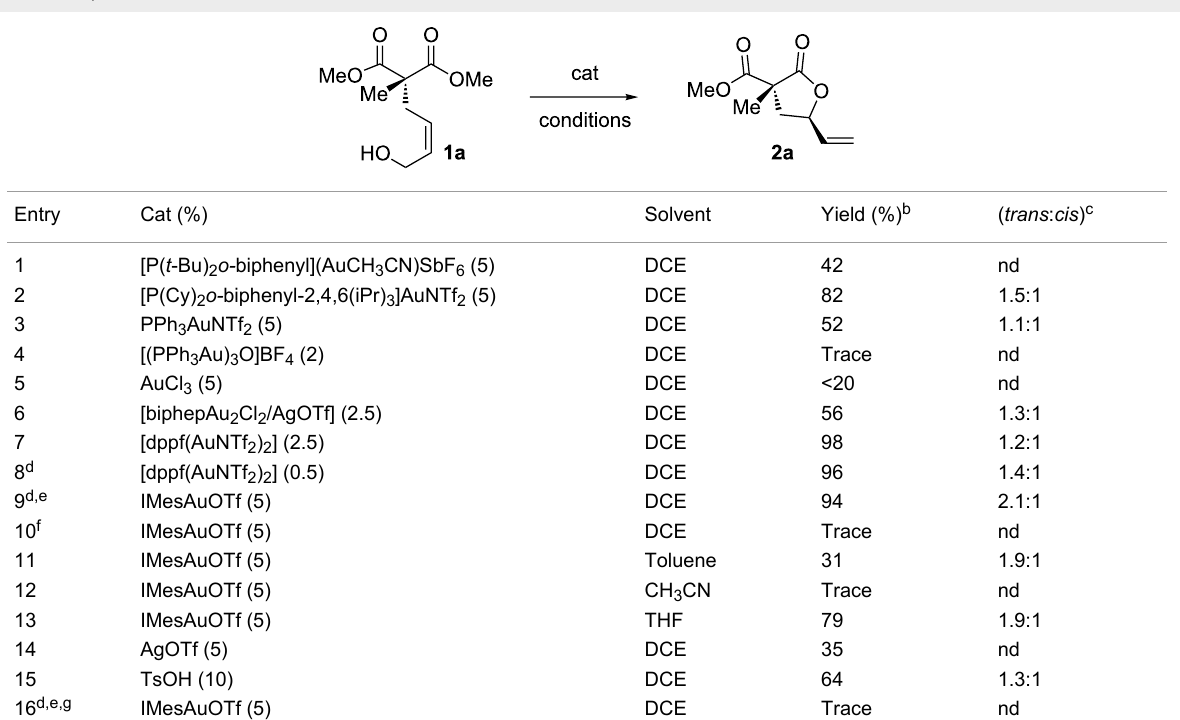
Table 1: Optimization of the reaction conditions for the lactonization of 1a .